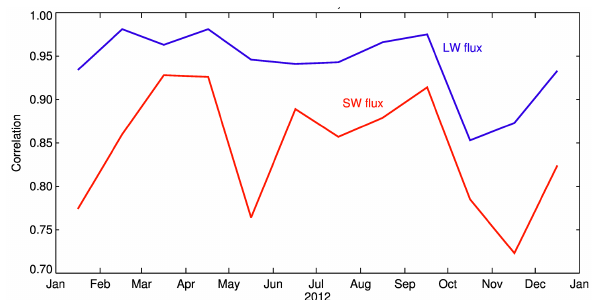
Figure 6. Correlation between short-range (0–24h) forecasts and observations of daily averaged values of downward shortwave and longwave flux at the ARAD WHW station. Monthly means for the verification period 1 Janary–31 December 2012 are